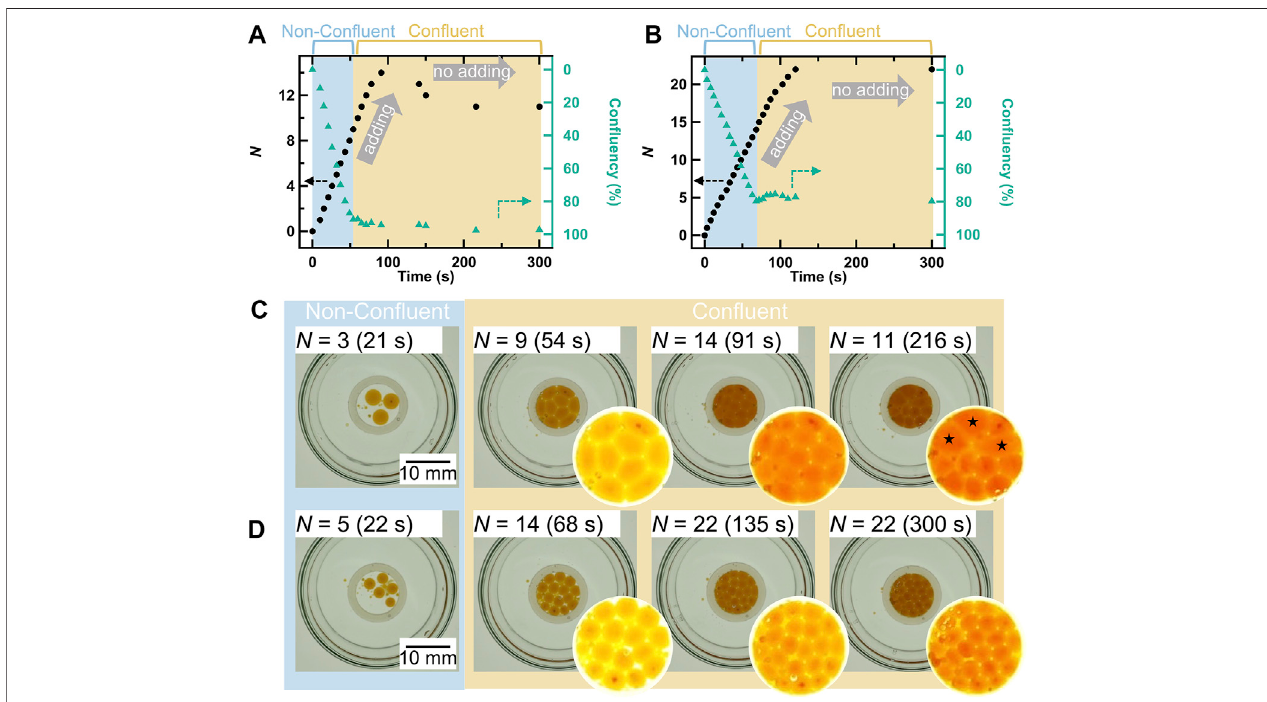
FIGURE 7 | Changes in the total number of droplets within the silicon ring ( N ) and con fl uency with time in the cases of (A) 10.0 μ l/droplet and (B) 5.0 μ l/droplet. Con fl uency was calculated asthe ratio between thetotal area occupied by all thedropletsand the area surrounded by thesilicon ring.The axis ofcon fl uency isinverted. The increasing N indicates that droplets were added, and stopping means that droplet addition was stopped. Top-view snapshots of the droplets and enlarged images showing the interior of the silicon ring in the cases of (C) 10.0 μ l/droplet and (D) 5.0 μ l/droplet. The + symbol represents coalescing droplets.